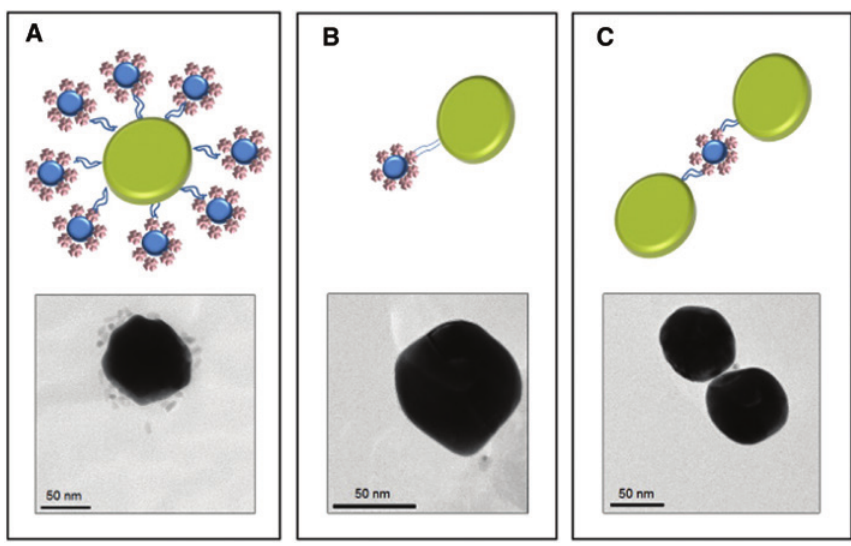
Figure 2: Depiction and corresponding TEM images of structures formed from AuNPs functionalized with ssDNA strands that are then hybridized with